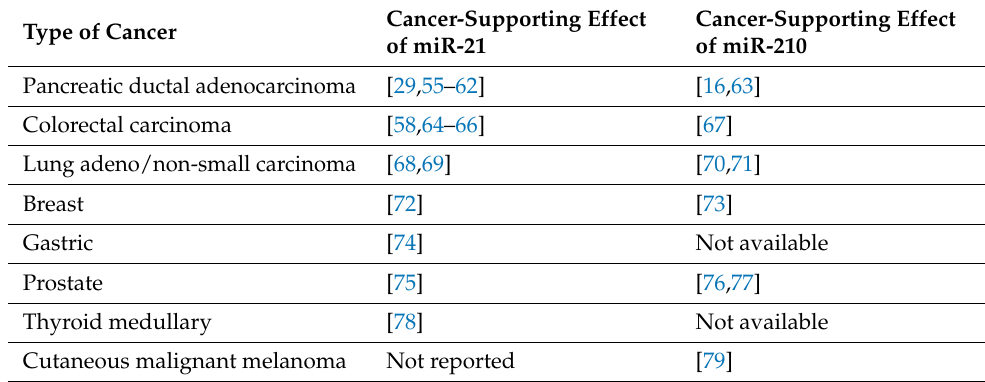
Table 1. Role of miR-21 and miR-210 expression by CAFs/stellate cells in cancer